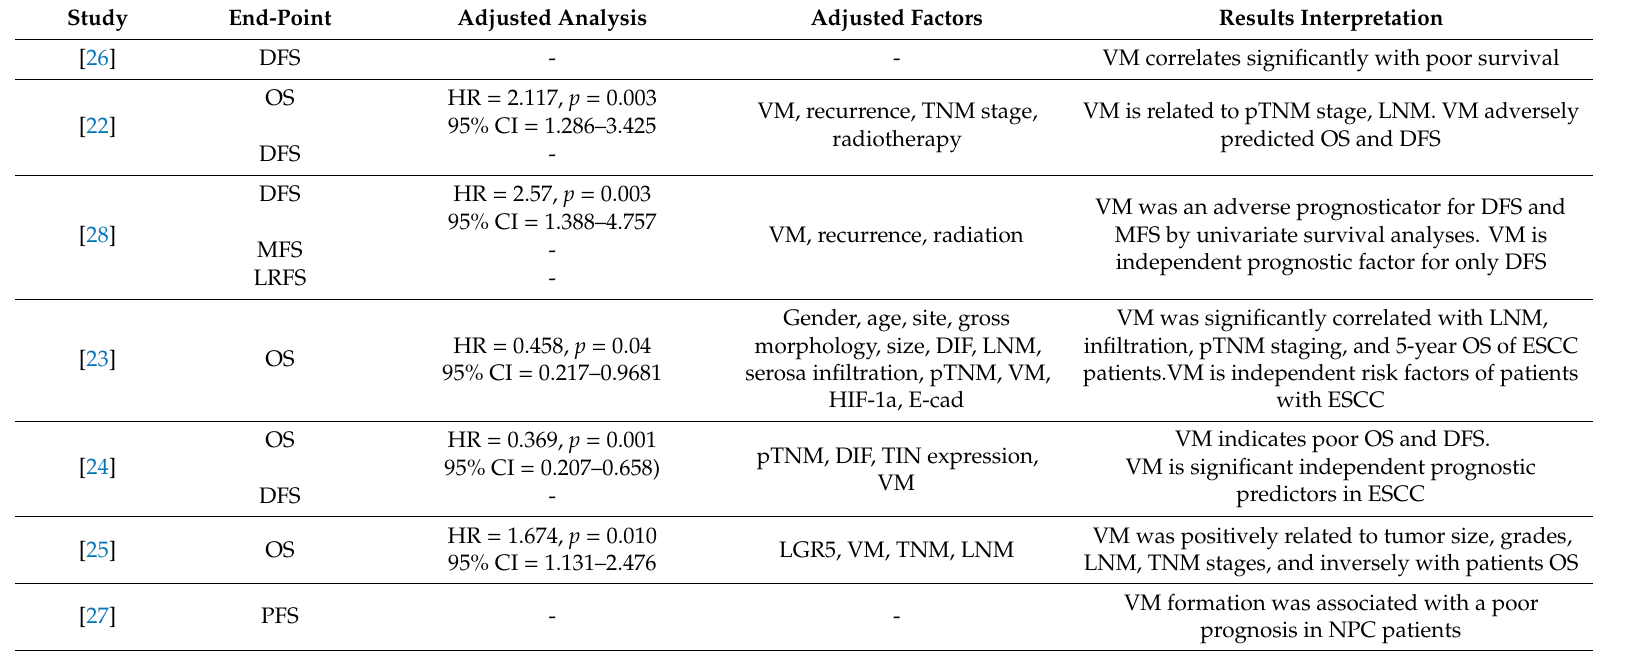
Table 4. Summary of the reported prognostic data and interpretation of the main